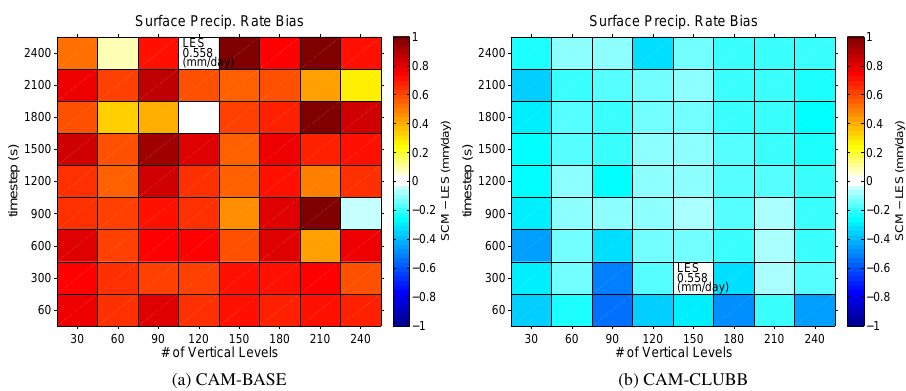
Fig. 3: Same as Fig. 1, except for the bias of surface precipitation rates from the RICO case of precipitating trade-wind cumulus, averaged over hours 18–24.